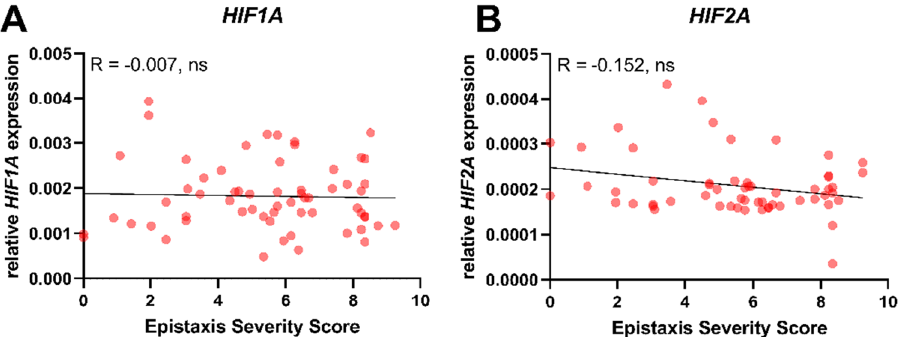
Figure 5. Correlation of HIF and Epistaxis Severity Score. Individual HHT patients’ Epistaxis Severity Score was correlated to individual relative HIF1A gene transcription (n = 62) ( A ) or individual relative HIF2A gene expression (n = 58) ( B ). Gene expression was calculated as 2-ΔCT expression with respect to ACTB. No significant correlation was observed. Data are presented as individual values; Spearman R test was used to assess the correlations. ns not